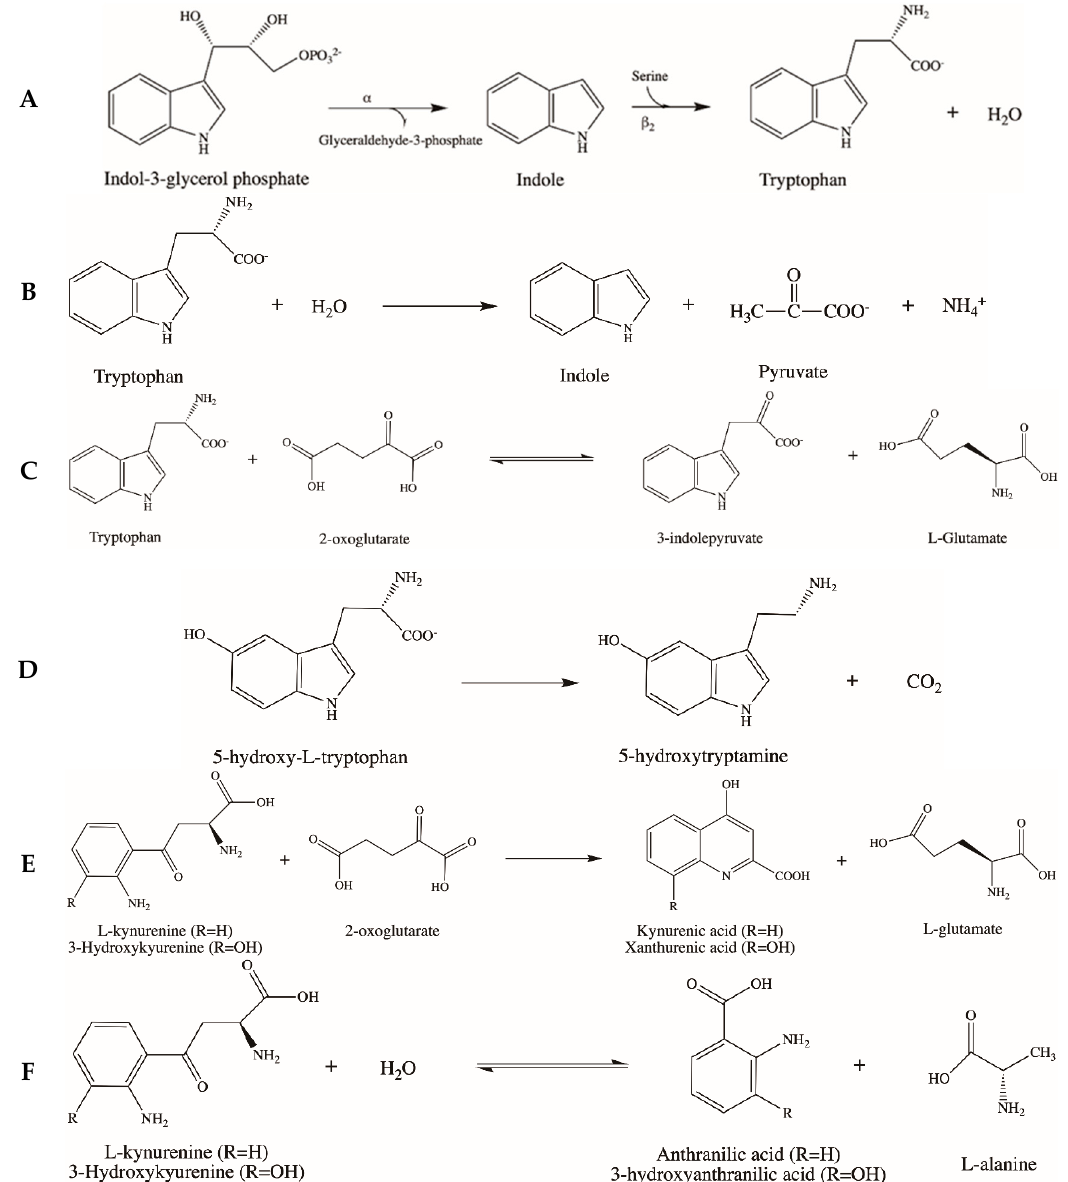
Figure 3. Schematic overview of the tryptophan metabolic pathways catalyzed by pyridoxal 5 ′ - phosphate enzymes. The panel illustrates the substrates and the products of the reactions catalyzed by tryptophan synthase (TS) ( A ), tryptophan indole lyase (Trpase) ( B ), aromatic amino acid aminotransferases (AroAT) ( C ), aromatic-L-amino acid decarboxylase (AADC) ( D ), kynurenine aminotransferase (KAT) ( E ), and kynureninase (KYNU) ( F ). Details are described in the text.